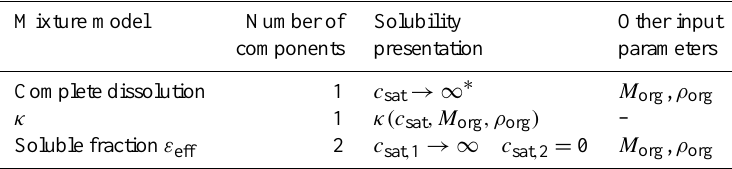
Table 1. Simplified descriptions of organic mixture solubilities. Mixture model Number of Solubility Other input components